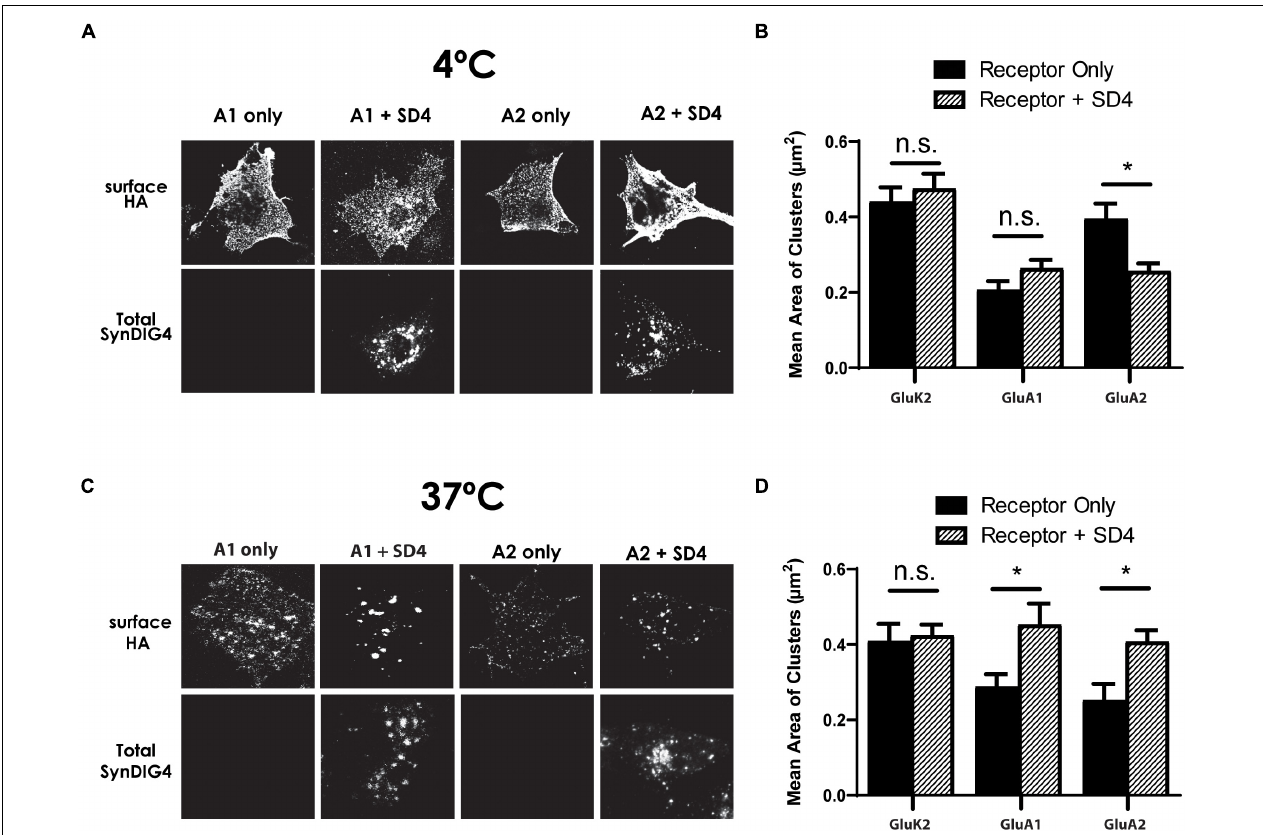
FIGURE 7 | Synapse differentiation-induced gene 4 clustering of GluA1 and GluA2 requires incubation at 37 ◦ C. (A) Representative confocal images of COS cells expressing either GluK2, GluA1, or GluA2 lone or co-expressed with SD4 after incubation at 4 ◦ C. (B) Graph depicts the mean area of receptor clusters. GluK2 alone ( n = 14), GluK2 + SD4 ( n = 12), GluA1 alone ( n = 10), GluA1 + SD4 ( n = 14), GluA2 alone ( n = 12), GluA2 + SD4 ( n = 13). (C) Representative confocal images of COS cells expressing either GluK2, GluA1, or GluA2 alone or co-expressed with SD4 after incubation at 37 ◦ C. GluK2 alone ( n = 11), GluK2 + SD4 ( n = 16), GluA1 alone ( n = 10), GluA1 + SD4 ( n = 10), GluA2 alone ( n = 10), and GluA2 + SD4 ( n = 10). (D) Graph depicts mean area of receptor clusters. Data are represented as mean ± SEM; n.s. not significant; * p < 0.05; one-way ANOVA with post-hoc Tukey’s